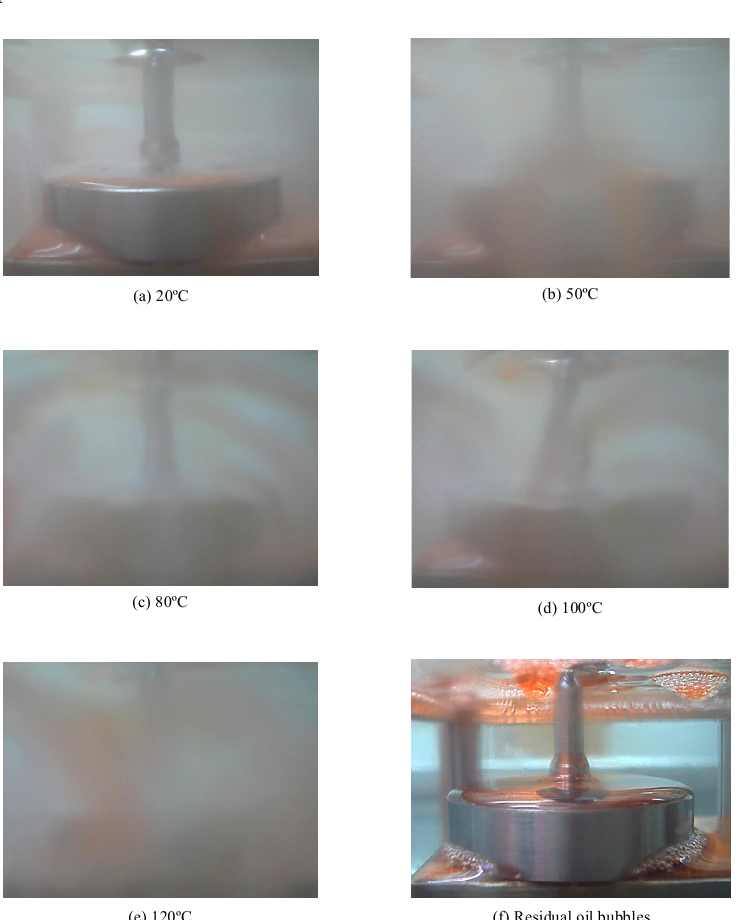
Figure 25. Cavitation phenomena with different temperatures. ( a ) Cavitation phenomenon with 20 °C; ( b ) Cavitation phenomenon with 50 °C; ( c ) Cavitation phenomenon with 80 °C; ( d ) Cavitation 20 ◦ C; ( b ) Cavitation phenomenon with 50 ◦ C; ( c ) Cavitation phenomenon with 80 ◦ C; ( d ) Cavitation phenomenon with 100 °C; ( e ) Cavitation phenomenon with 120 °C; ( f ) Cavitation phenomenon with phenomenon with 100 ◦ C; ( e ) Cavitation phenomenon with 120 ◦ C; ( f ) Cavitation phenomenon with residual oil bubbles. residual oil